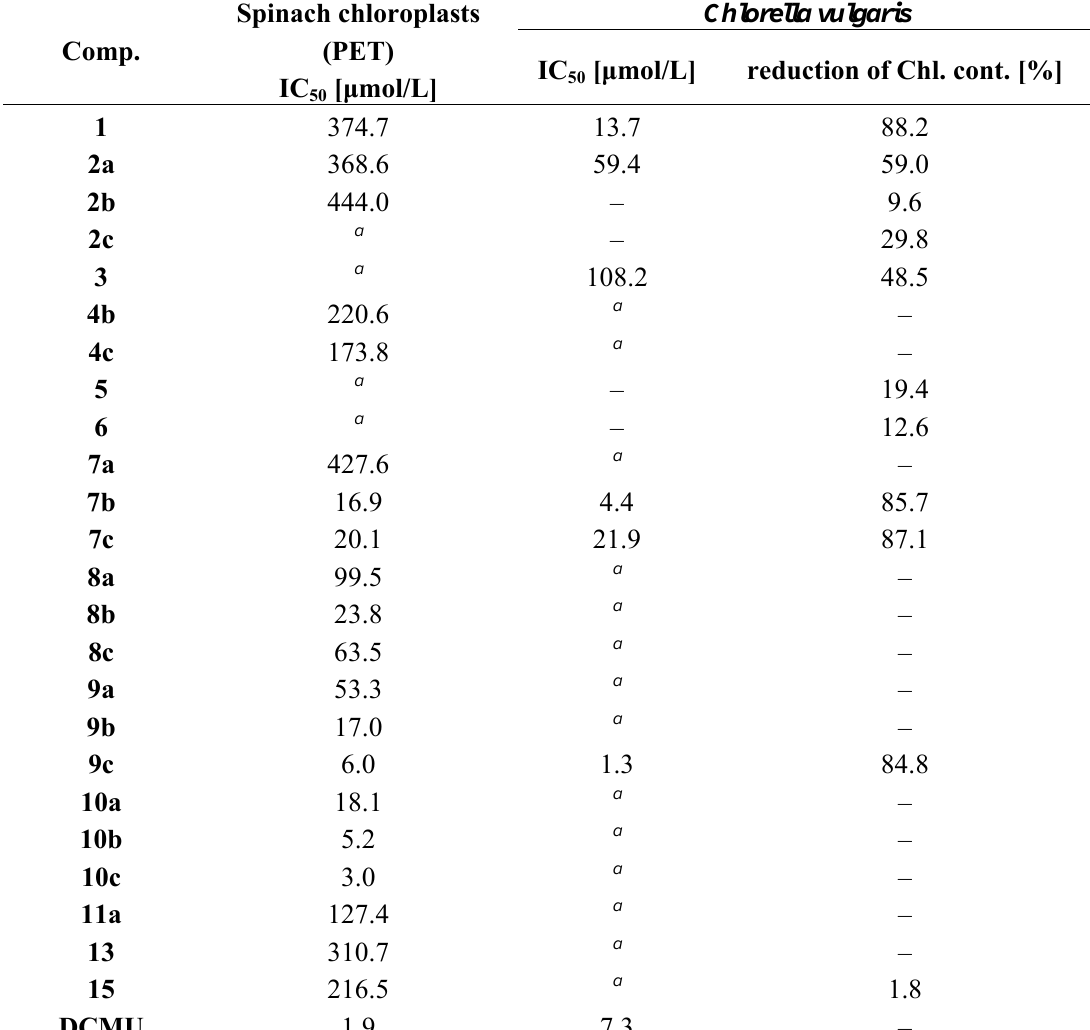
Table 2. The inhibitory activity of the selected rhodanine derivatives related to the inhibition of photosynthetic electron transport (PET inhibition) in spinach chloroplasts ( Spinacia oleracea L.) as well as their activity related to the reduction of chlorophyll values or as reduction of chlorophyll content in Chlorella vulgaris (expressed as IC 50 content [%] caused by application of 100 μ mol/L of the studied compound) in comparison with standard 3-(3,4-dichlorophenyl)-1,1-dimethylurea DCMU. Spinach chloroplasts Chlorella vulgaris (PET) Comp. IC [ μ mol/L] reduction of Chl. cont. 50 IC [ μ mol/L] 50